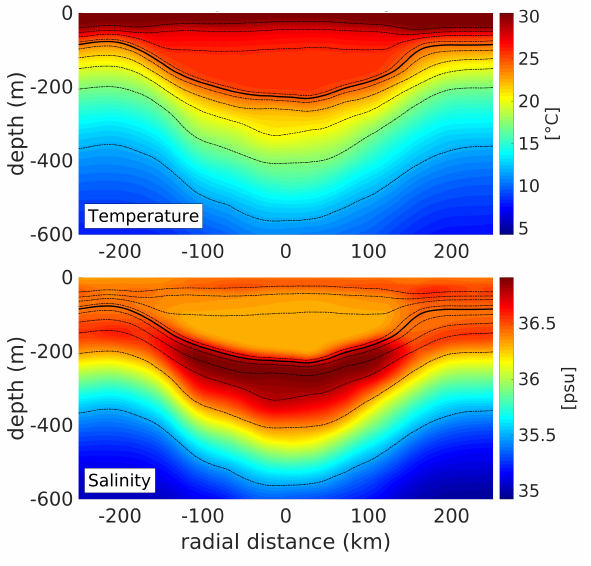
Figure 8. Temperature ( ◦ C) and Salinity (psu) sections in corrected horizontal coordinates. The isopy- cnals are shown as black dotted lines. The thick contour represents the 25-isopycnal (1025 kg m − 3 ) and the contour spacing is of 0.5 kg m − 3